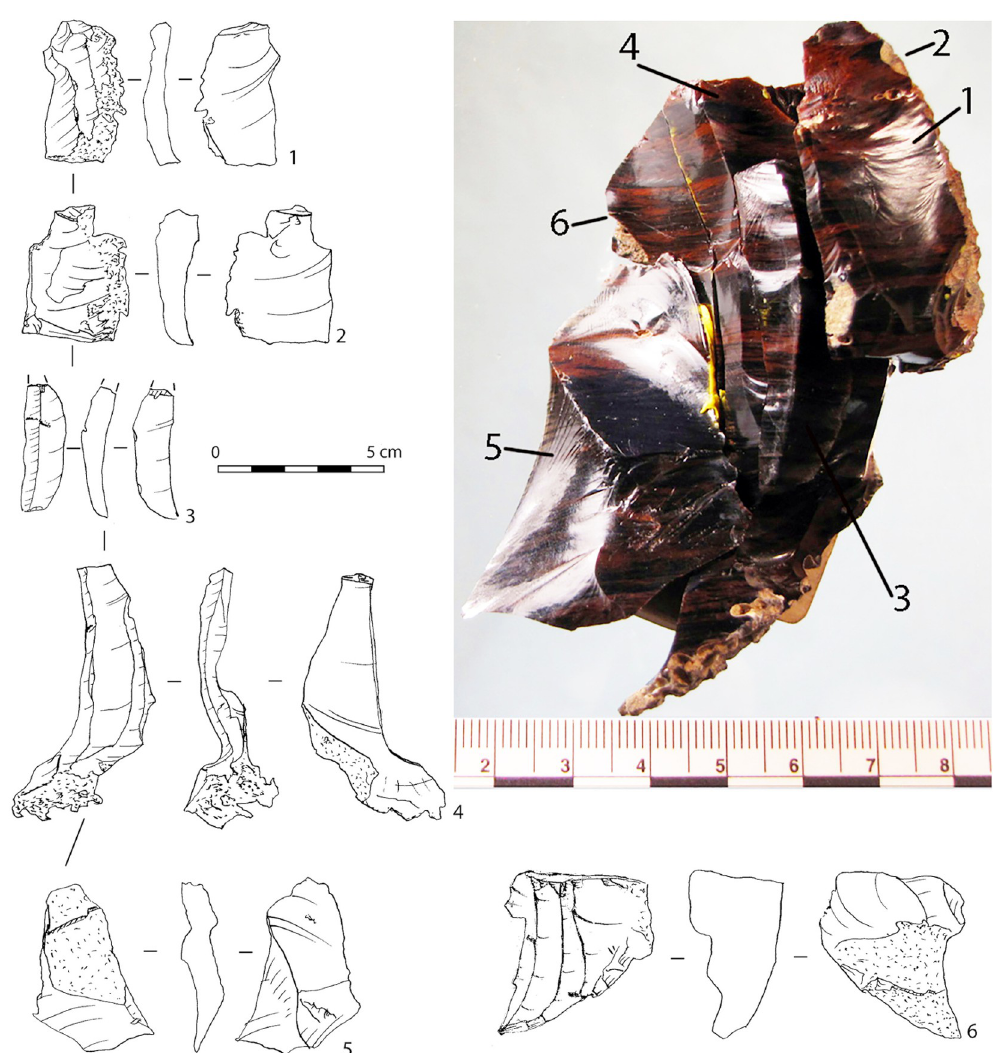
Fig 3. Saradj-Chuko grotto. 2017 excavation. Layer 6B. Drawing and photo of refitting of a one-platform core and five flakes, three of which are laminar flake (1) and blades (3, 4). Numbers indicate the sequence of